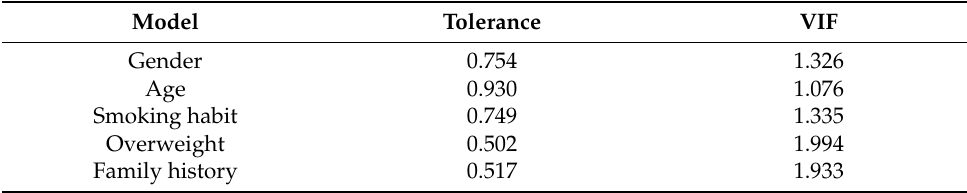
Table 5. Multicollinearity Test Results.